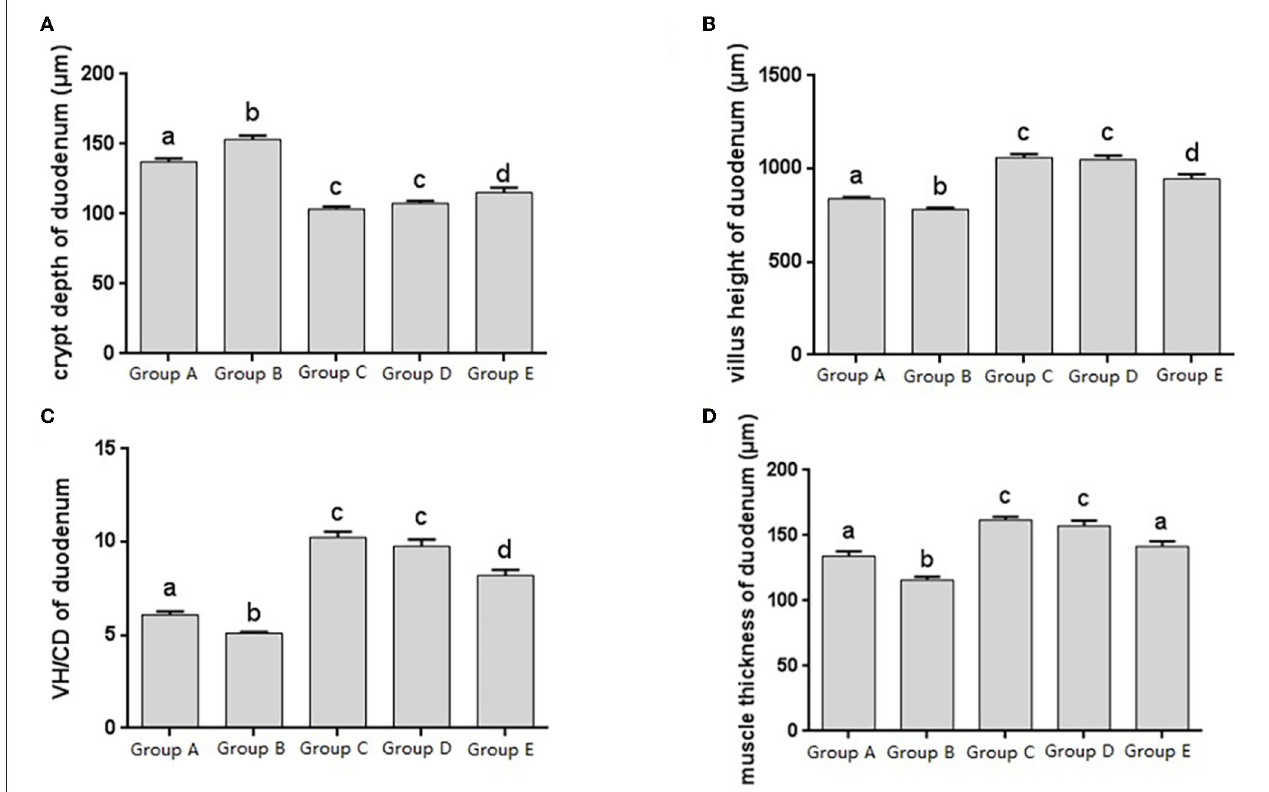
FIGURE 2 | Morphological changes in the duodenum of chicks after different treatments. (A) Crypt depth (CD) of the duodenum. (B) Villus height (VH) of the duodenum. (C) VH/CD of the duodenum. (D) Muscle thickness of duodenum. Group A, control group; Group B, infection group; Group C, JYBR-190 pre-fed group; Group D, JYBR-190 fed group; Group E, antibiotic group. Data are expressed as mean ± standard deviation (SD). Different lowercase letters on the columns indicate significant differences ( P < 0.05); the same lowercase letters indicate no significant difference ( P > 0.05).